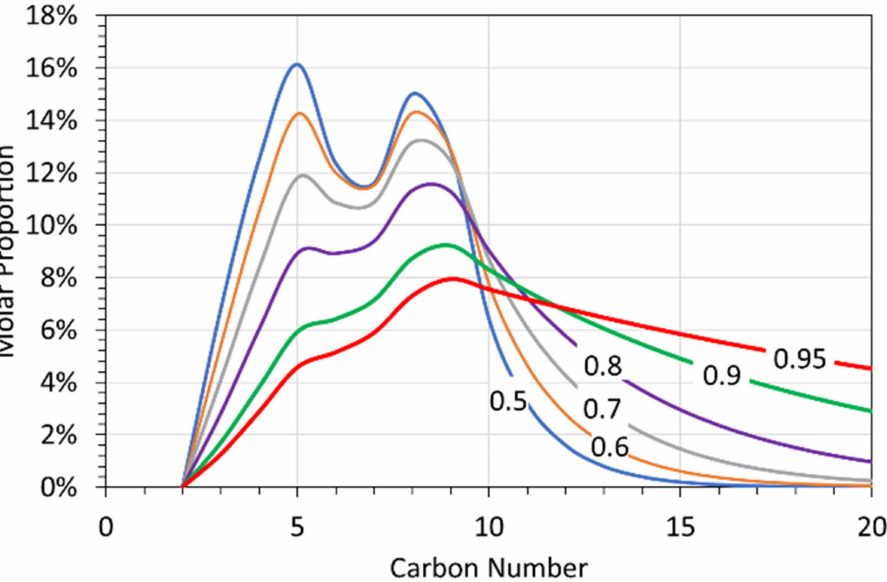
Figure 8. Average liquid alkane composition, produced at < 298 K, where the alkanes were subse- quently grown at ASF α values of 0.5 to 0.95. Blue line = ASF α value of 0.5; Brown line = ASF α value of 0.6; Grey line = ASF α values of 0.7; Purple line = ASF α values of 0.8; Green line = ASF α values of 0.9; Red line = ASF α values of 0.95; Appendix B Figure A1 gives the probability values for the alkane composition when the ASF α value is